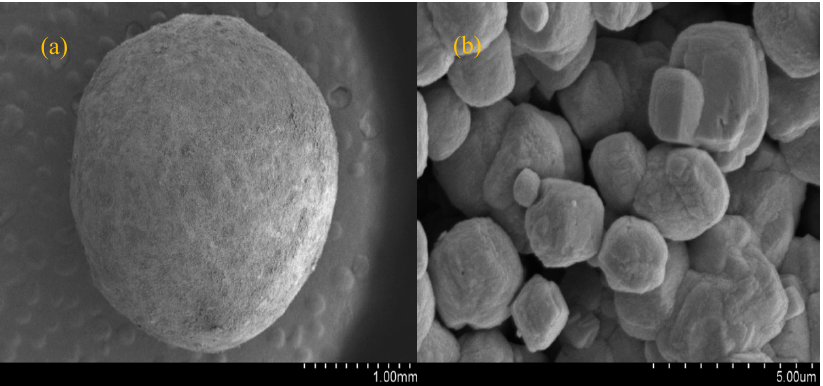
Figure 5. Scanning electron micrograph of modified ceramsite: ( a ) 1 mm; ( b ) 5 µm.